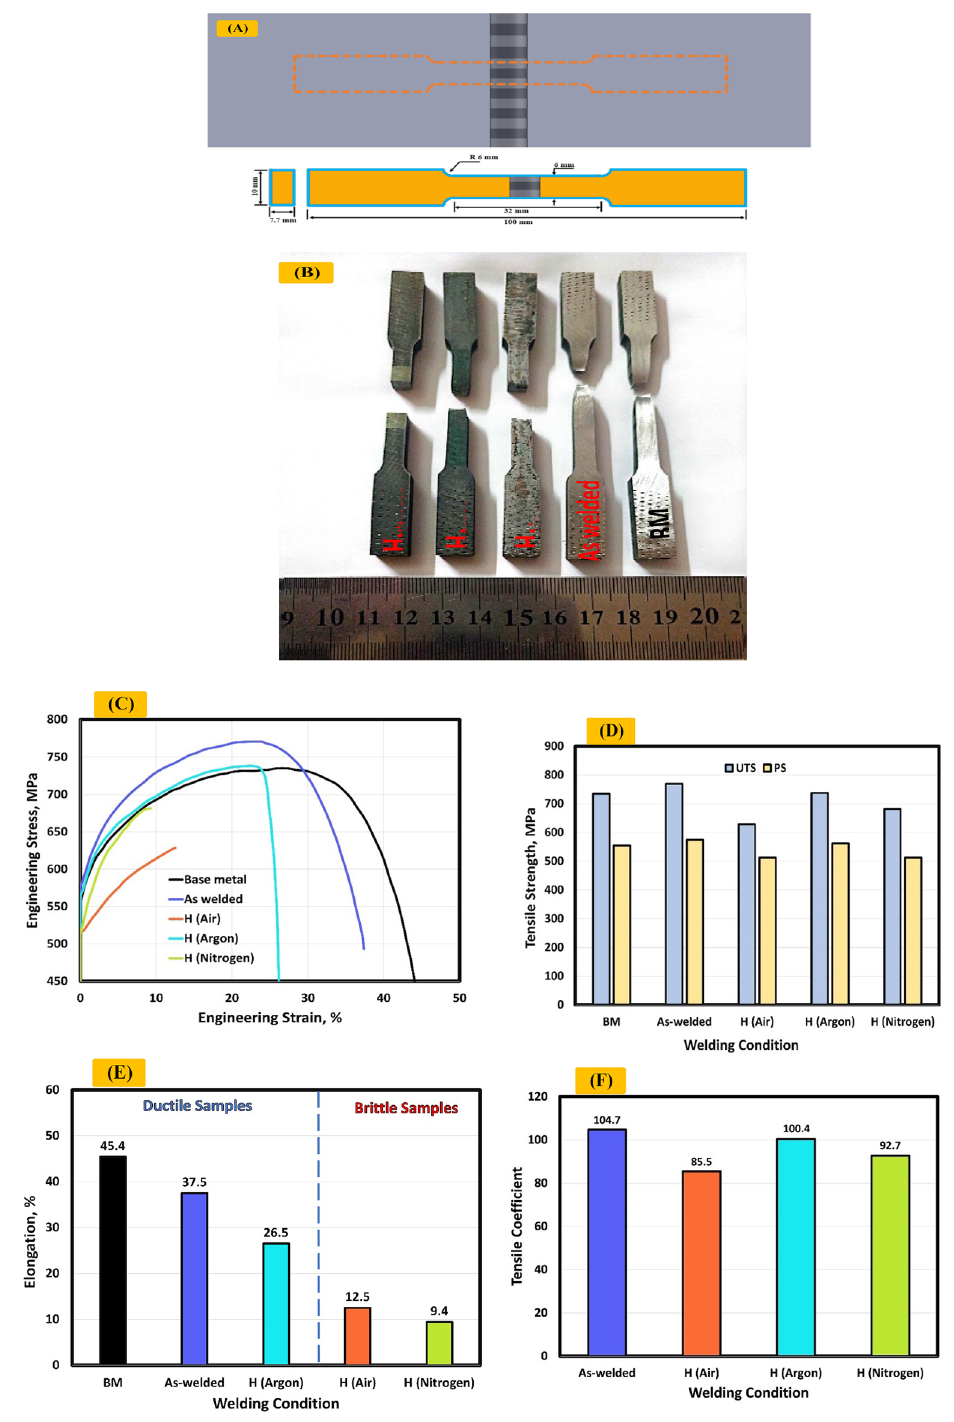
Figure 18. ( A ) Dimensions of tensile samples, ( B ) fractured tensile specimens, ( C ) engineering stress–strain curves of (W, H Air , H Argon , H Nitrogen ) samples, ( D ) value of ultimate tensile strength and proof, ( E ) percentage elongation of samples, ( F ) tensile